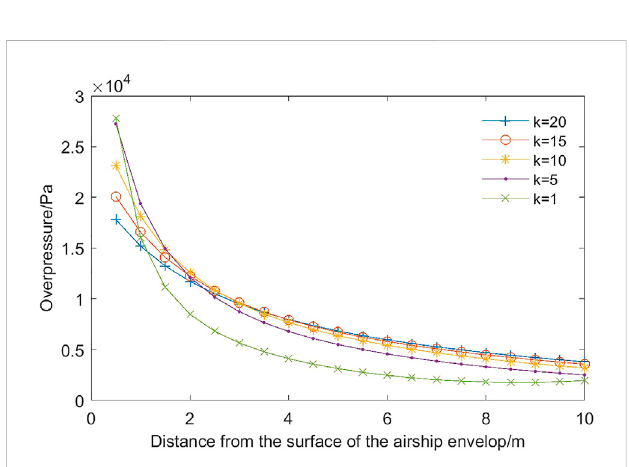
FIGURE 6 Overpressure for envelopes with different geometric scale ratios.